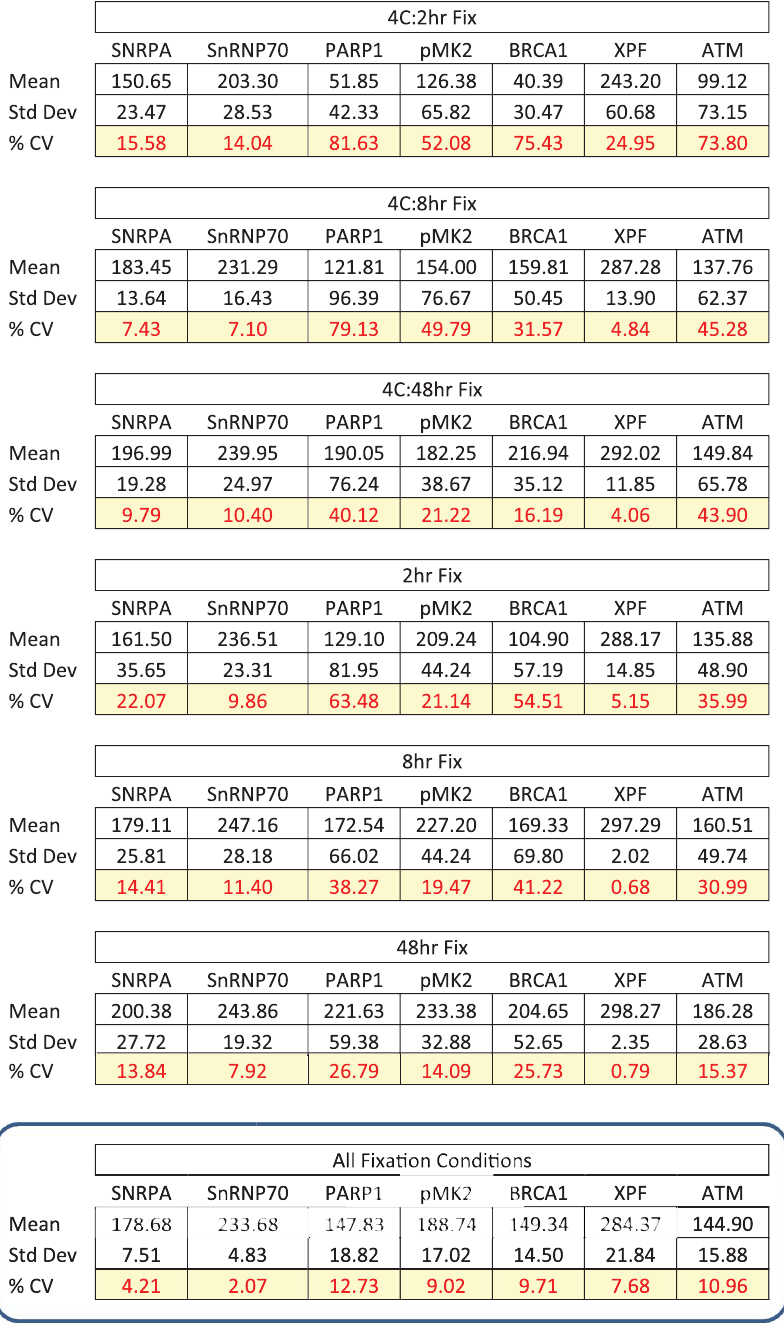
Fig. 6. Variation as measured by mean H-score and %CV for given biomarkers and different fixation conditions. The H-scores for each of 6 patients for a given biomarker were averaged per fixation and Std Dev and %CV calculated. Additionally all fixation conditions for all patients were averaged to gain average %CV for a given